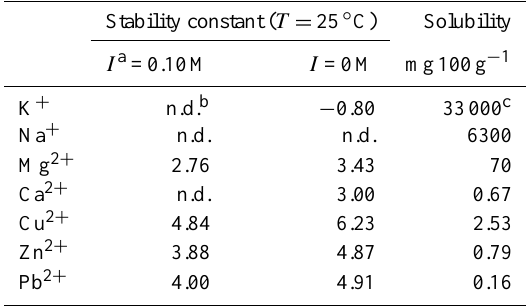
Table 1. Stability constant (log K) of oxalate with some metal ions at 25 ◦ C (Martell and Smith, 1977) and the solubility of the com- plexes in water (David,